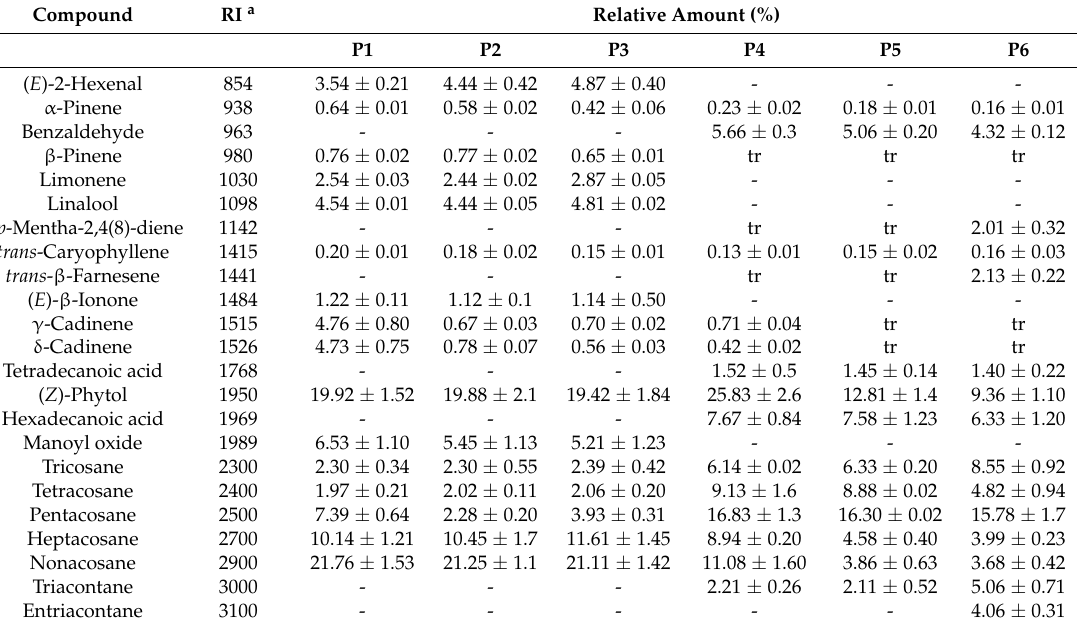
Table 1. The main volatiles of P. armeniaca (P1–P3) and P. domestica (P4–P6) leaves essential oils. Compound RI